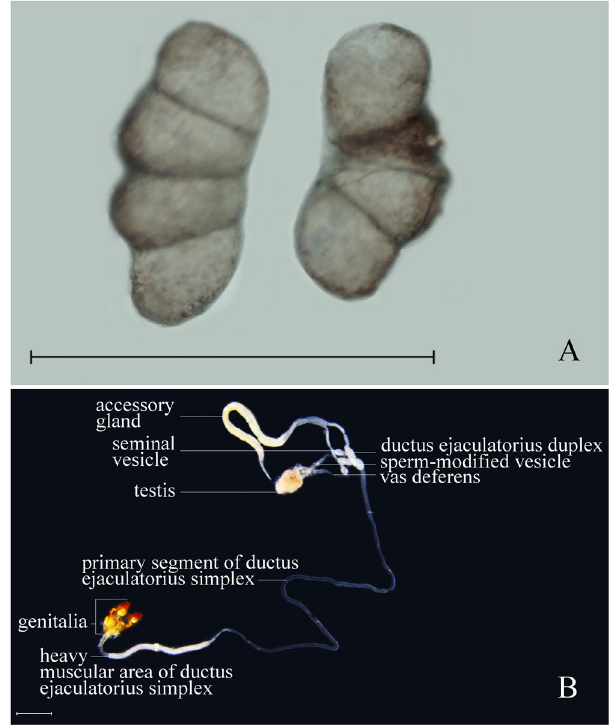
Figure 1. Male reproductive system of OFM. ( A ) Testis of 3rd instar larvae ( B ) Reproductive system of male adults. Scales = 1.0